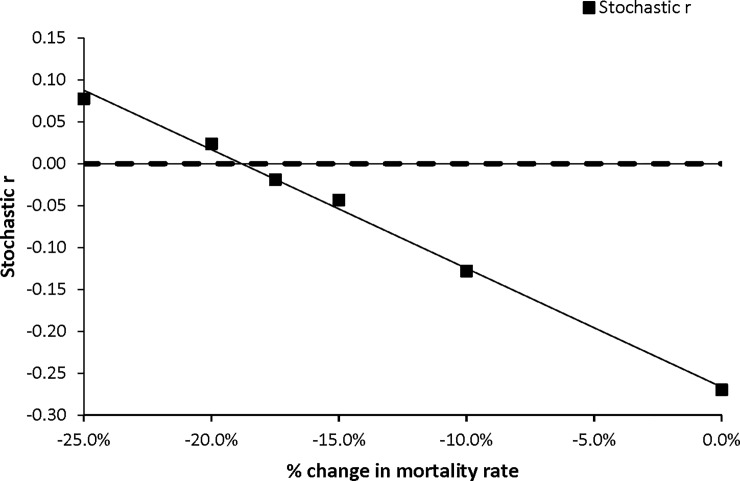
Evaluation of varying mortality rate to achieve a stable growth rate in Vortex.